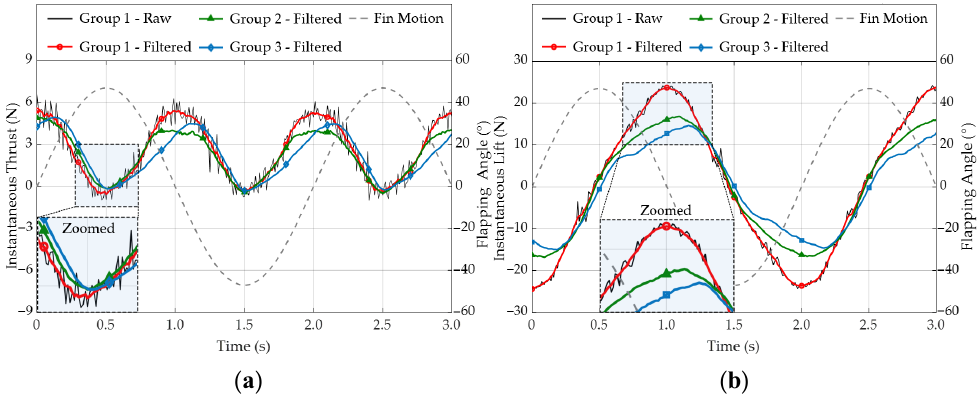
Figure 8. Instantaneous thrust and lift of different test groups. ( a ) Trajectories comparison of the instantaneous thrust; ( b ) Trajectories comparison of instantaneous lift. instantaneous thrust; ( b ) Trajectories comparison of instantaneous